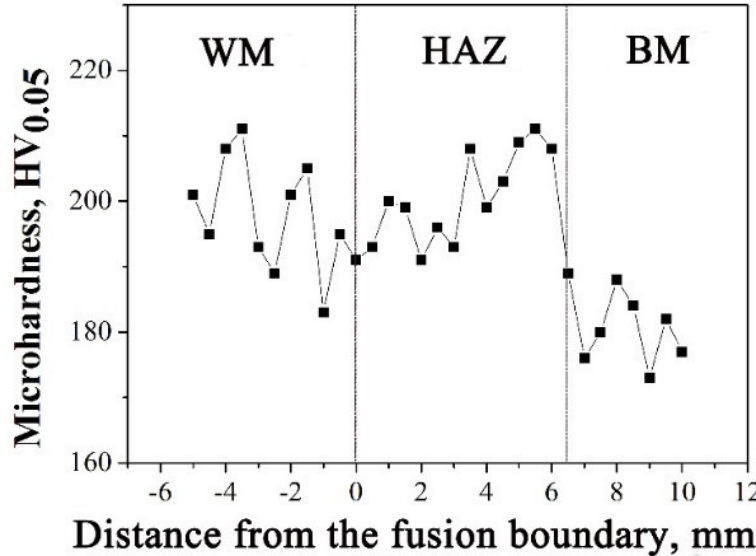
Figure 8. Microhardness distribution of the 308L-316L welded joint.